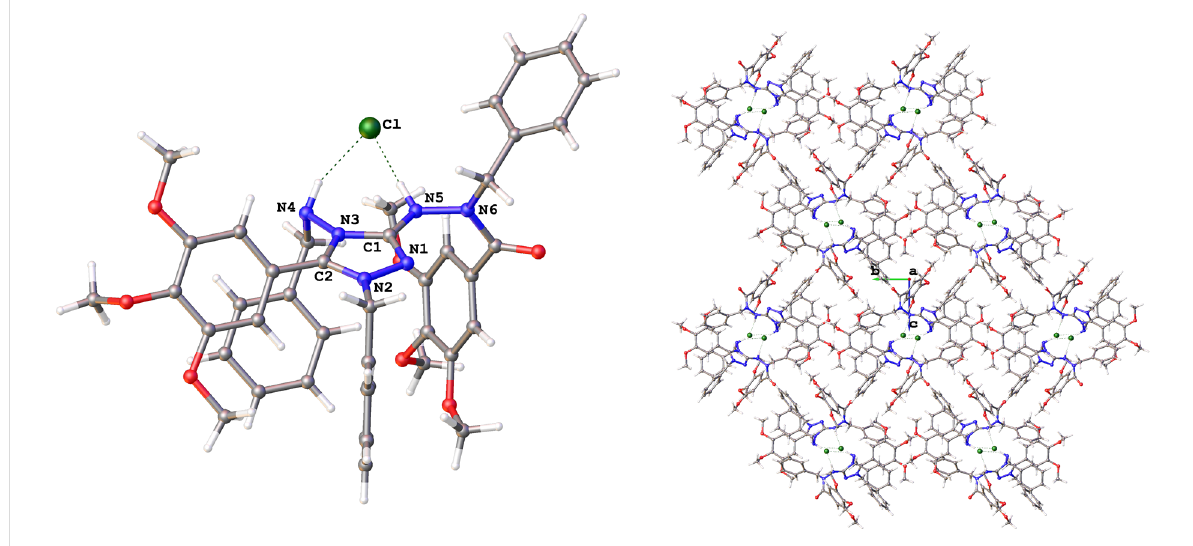
Figure 2: Left: molecular structure of 8b in the solid state (OLEX2 plot). Right: crystal structure viewed along the crystallographic a -axis. Selected bond lengths (Å): C1–N1 1.317(2), C1–N3 1.372(2), C1–N5 1.349(2), N1–N2 1.388(2), C2–N2 1.319(2), C2–N3 1.352(2), N3–N4 1.412(2). Hydrogen